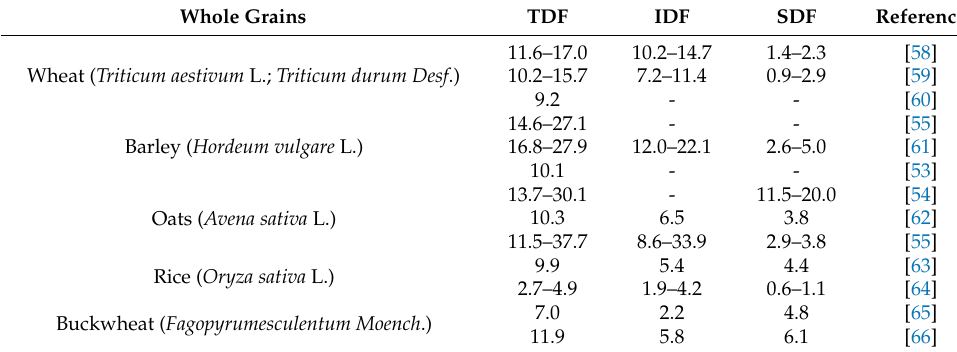
Table 3. The dietary fibre content of five whole grains (g/100 g). Whole Grains TDF IDF SDF Reference Wheat ( Triticum aestivum L.; Triticum durum Desf .) Barley ( Hordeum vulgare